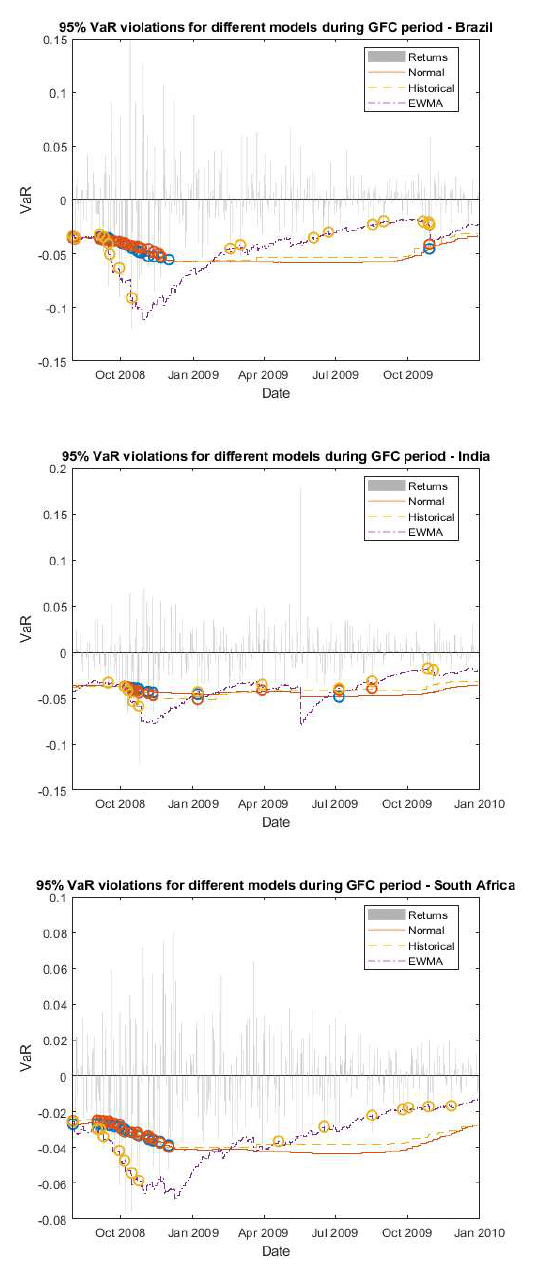
Figure 2. Comparison of returns and VaR at 95% for different models (GFC,